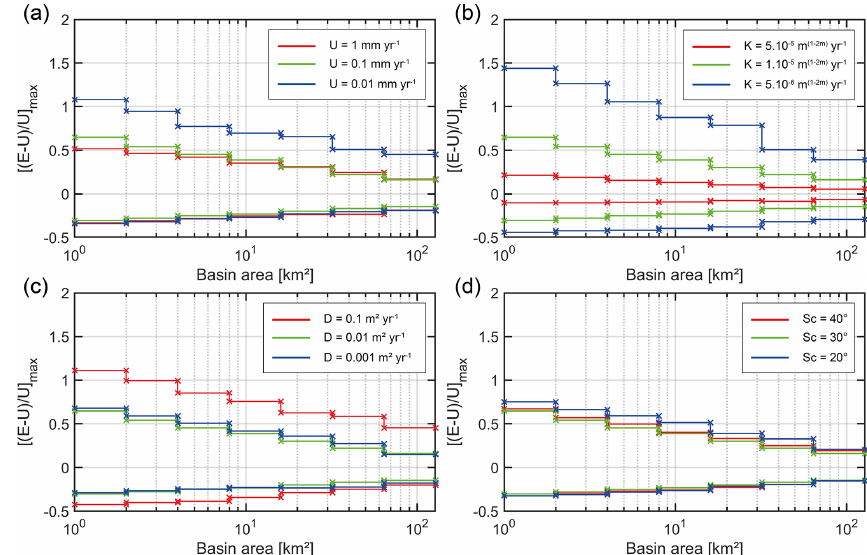
Figure 13. Deviation from steady state due to drainage migration as a function of basin size. Colour lines show the maximum dispersion of denudation rates (0.5 and 99.5 percentiles) due to divide mobility. Green lines indicate the reference model. Seven sets of basin size are considered: 1–2, 2–4, 4–8, 8–16, 16–32, 32–64 and 64–128km 2 every 0.5Myr between 5 and 10Myr. (a) Effect of uplift rate. (b) Effect of erodibility. (c) Effect of diffusivity. (d) Effect of critical